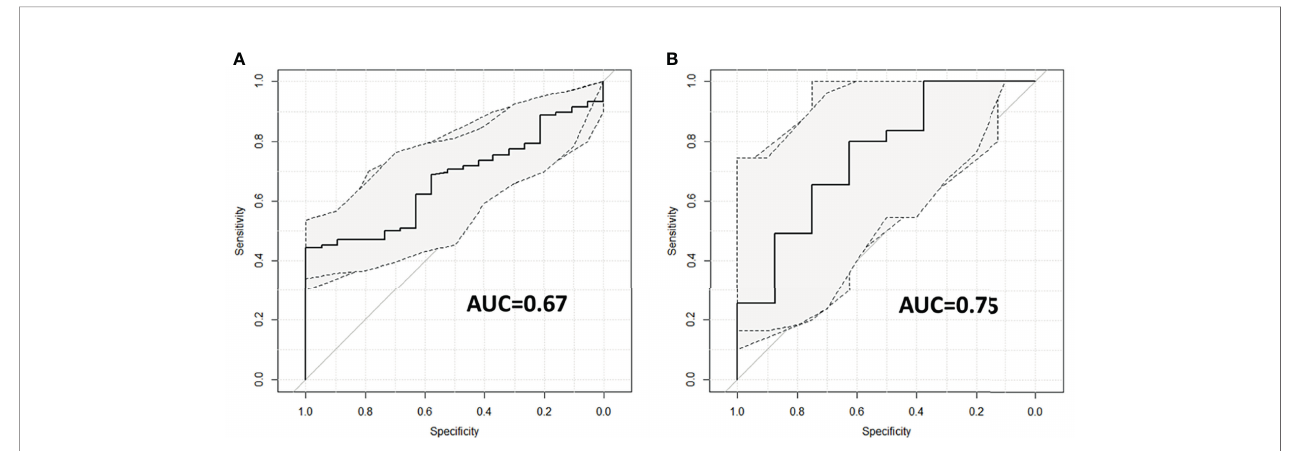
FIGURE 3 | ROC curves with corresponding 95% CIs for patients treated with (A) and without (B) oxaliplatin. ROC, receiver operating